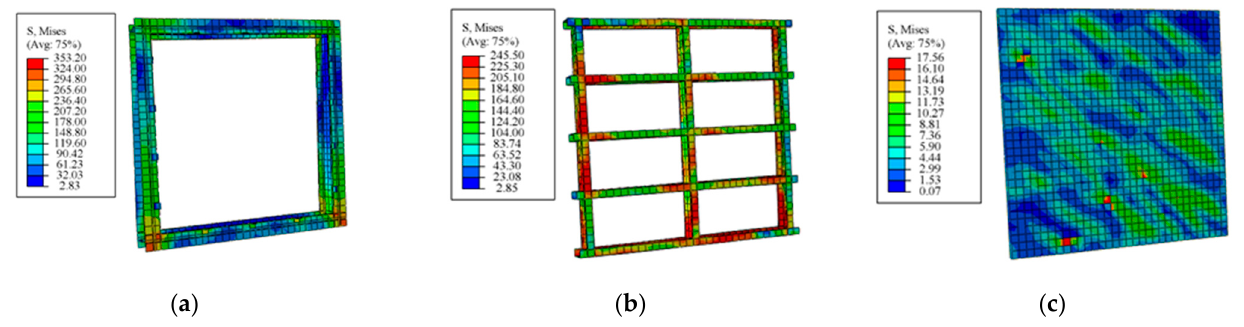
Figure 20. The Von Mises stress distribution of some parts: ( a ) steel frame; ( b ) C-shaped steel; ( c ) fine aggregate concrete. Table 5. Load capacity comparison between the test and the FE model.